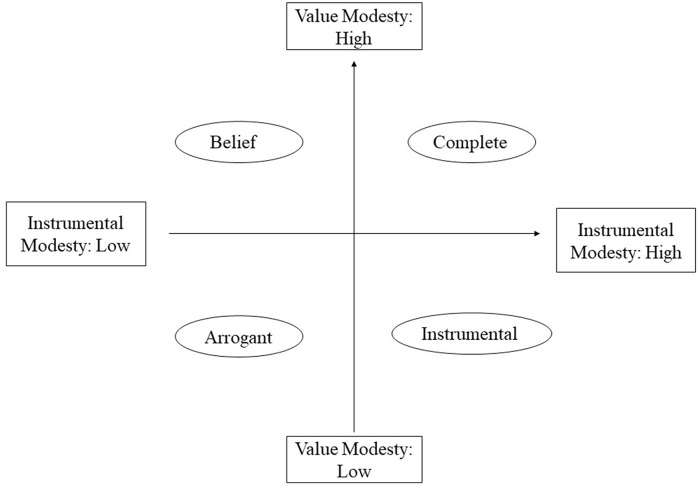
The dualistic model of value and instrumental modesty (Wang et al., 2016).